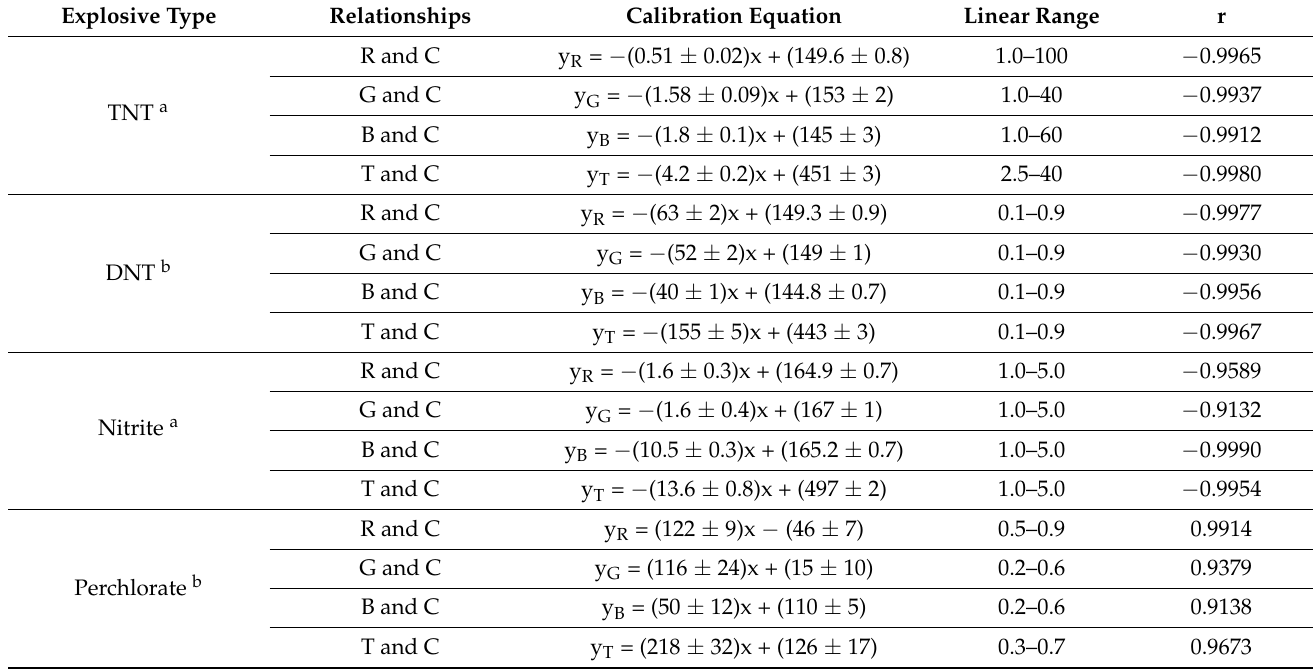
Table 2. The calibration equations for the quantification of the four explosives studied.